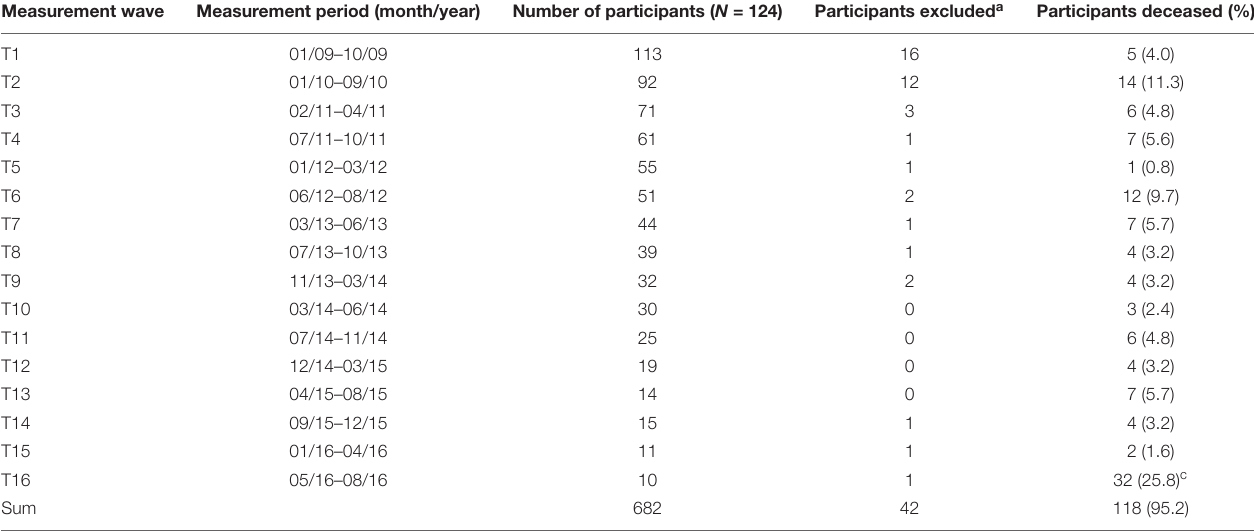
TABLE 1 | LateLine study – measurement times, numbers of participants, and participants deceased between measurement occasions. Measurement wave Measurement period